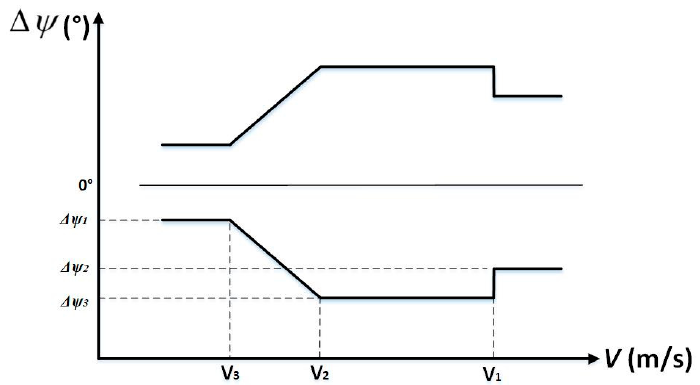
Figure 2. The designed error corridor of the azimuth schematic. The bank reversal logic of the vehicle in the gliding phase is designed similarly to the lateral steering logic of a shuttle and consists of the following main scenarios: when the azimuth error value lies within the error corridor, | ∆ ψ | ≤ | ∆ ψ max | , the sign of the bank angle is unchanged; however, when it exceeds boundary of the designed error corridor, the sign of the bank angle changes. To further improve guiding accuracy, the azimuth error corridor can then be adjusted appropriately for the specific interface of the entry